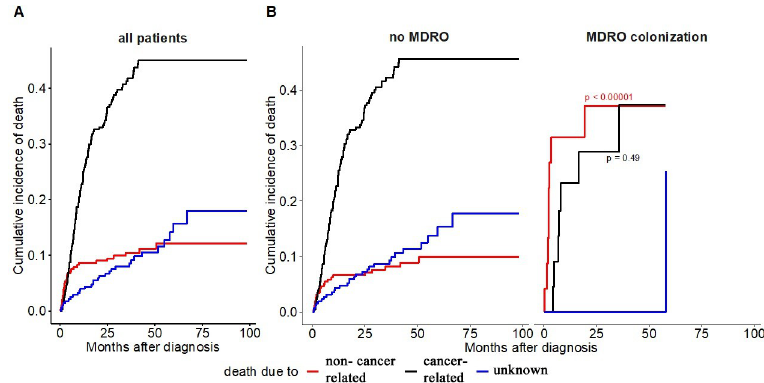
Fig 4. Cumulative incidence of death stratified by non-cancer related and cancer related mortality (A) in the whole study group. (B) stratified by MDRO colonization.